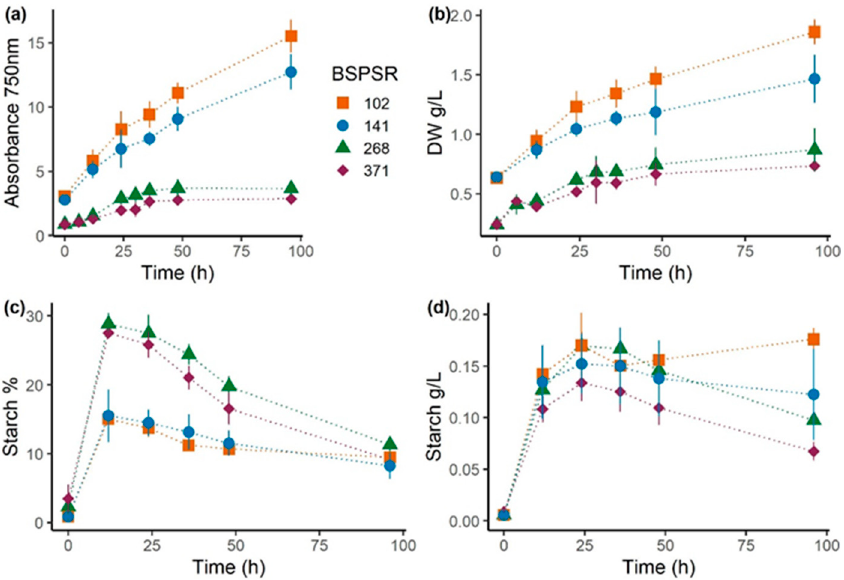
Figure 4. Time course over 96 h after N starvation expressed as average of triplicate cultures in experiment 2: ( a ) culture density expressed as absorbance at 750 nm; ( b ) culture density expressed as biomass dry weight; ( c ) starch concentration expressed as % of biomass dry weight; ( d ) starch concentration expressed as grams per litre.